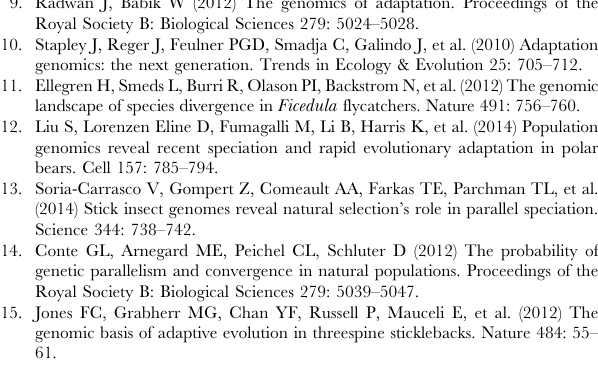
Figure S3 Comparison of mean frequencies of freshwater alleles at marker SNPs located within and outside of DIs defined by only one marine-freshwater population pair, at freshwater populations of different ages. Each two boxes correspond to the four young freshwater populations (anadromous from Lake Ershovskoye, Lake Martsy, Quarry Malysh, Quarry Goluboy). Dashes, boxes and whiskers correspond to the median, standard deviation, and 5 th and 95 th percentiles, respectively. Red, marker SNPs (under the